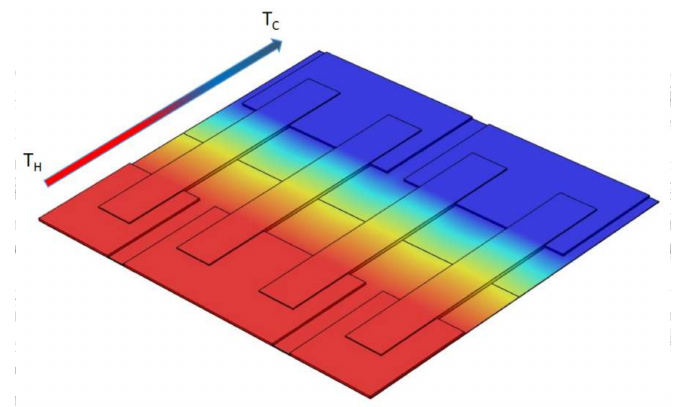
Figure 1. Lateral heat transfer configuration for printed thin-film thermoelectric generators